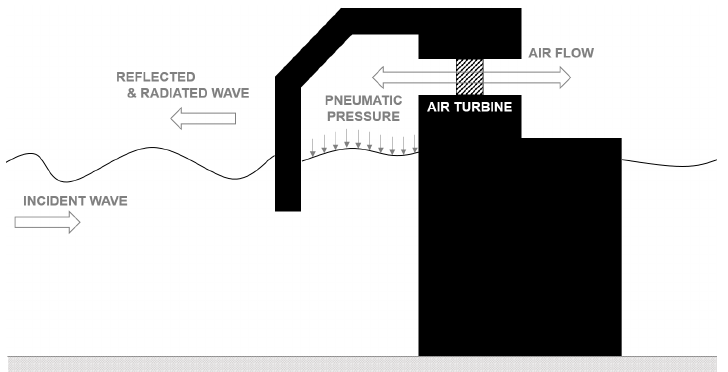
Figure 1. Schematic diagram of hydrodynamic energy conversion to pneumatic energy in the OWC-WEC with turbine–chamber